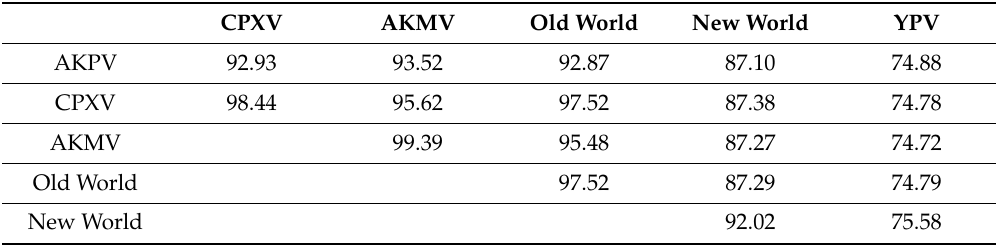
Table 1. Average percent nucleotide identity of the conserved core region of the Alaskapox virus isolate (AKPV), representative Cowpox virus (CPXV), Akhmeta virus (AKMV), Old World OPXV (Old World), New World OPXV (New World) and Yoka poxvirus (YPV) genomes (Table S1). Gaps were not included in this